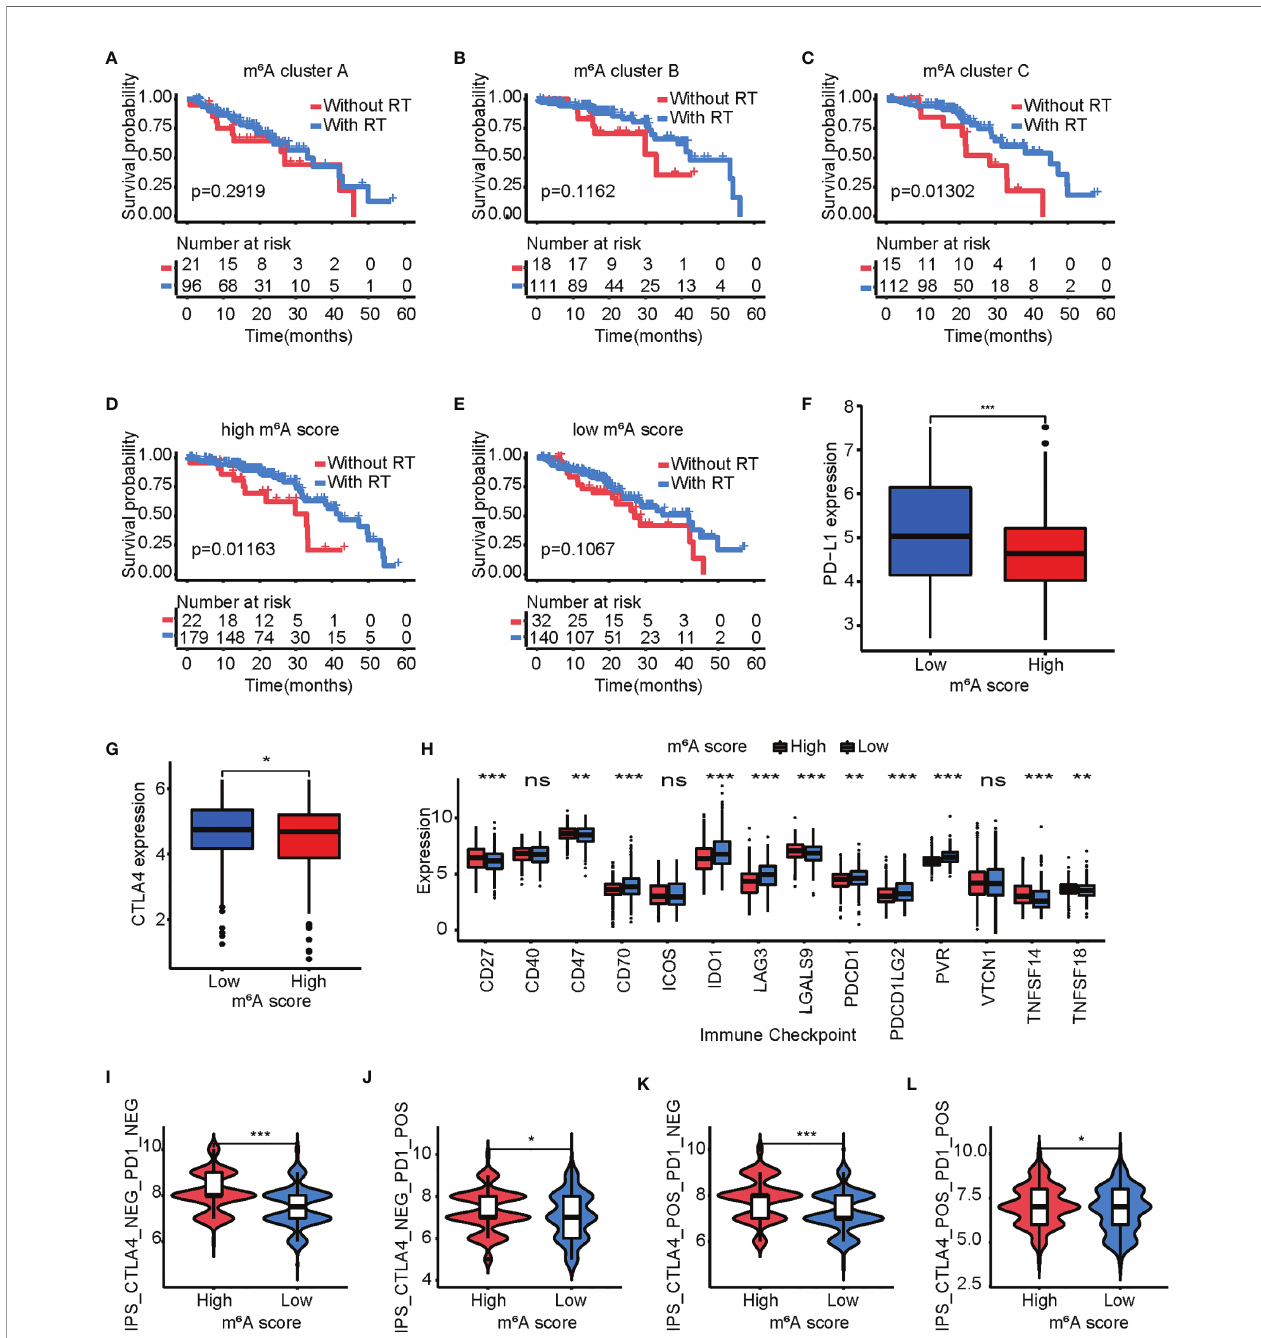
FIGURE 8 | The m 6 A score model predicts the bene fi ts of radiotherapy and immunotherapy. (A – C) Kaplan-Meier curves of overall survival for patients in m 6 A cluster A (A) , m 6 A cluster B (B) , and m 6 A cluster C (C) based on acceptance/rejection of radiotherapy. Log-rank test. (D, E) Kaplan-Meier curves of overall survival for patients with a high (D) /low (E) m 6 A score based on acceptance/rejection of radiotherapy. Log-rank test. (F, G) Comparison of the PD-1 (F) /CTLA4 (G) expression levels between the high and low m 6 A score groups. Log-rank test. (ns p > 0.05;* p < 0.05; ** p < 0.01; *** p < 0.001). (H) Differences in the expression of other immune checkpoints between the high and low m 6 A score groups. Log-rank test. (* p < 0.05; ** p < 0.01; *** p < 0.001). (I – L) Box plot representing the relative distribution of the immunophenoscore between the low and high m 6 A score groups in LUAD patients based on TCIA database, (I) CTLA4 − PD1 − ; (J) CTLA4 − PD1 + ; (K) CTLA4 + PD1 − ; and (L) CTLA4 + PD1 + . The asterisks represented the statistical p-value (* p < 0.05; *** p <